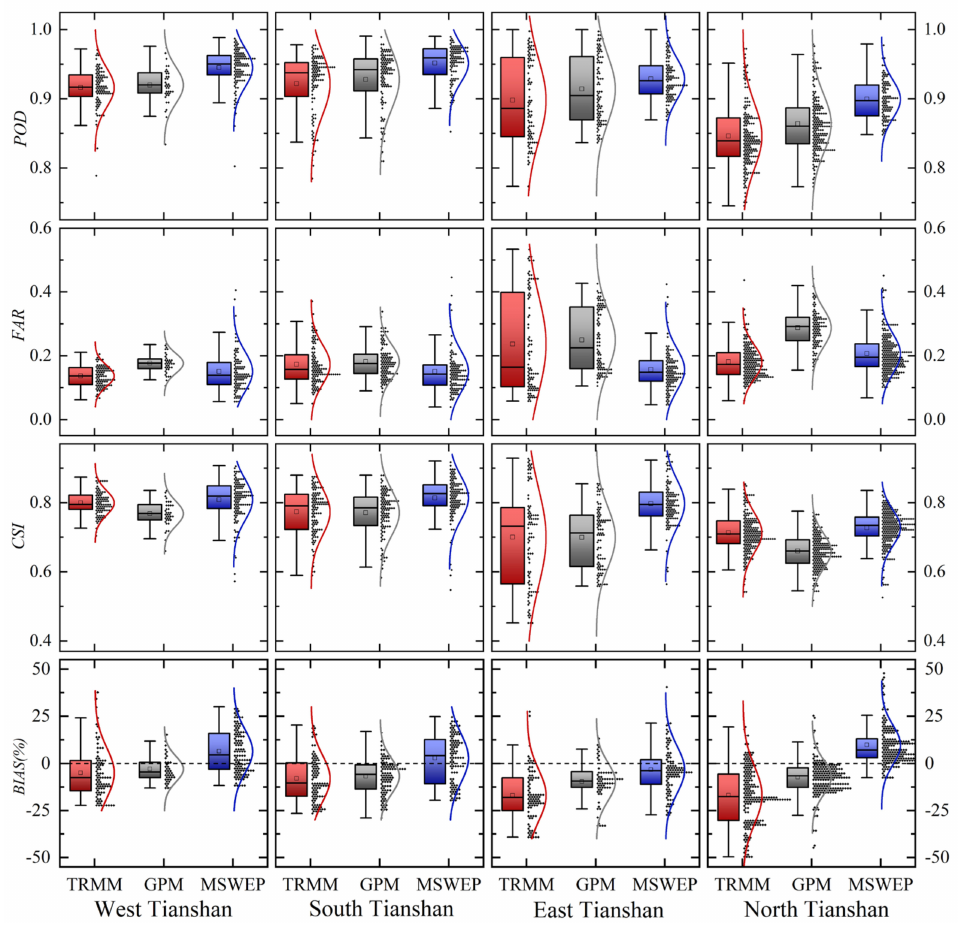
Figure 5. Statistical analysis of POD, FAR, BIAS and CSI of different precipitation products in different regions. In the box plot, the solid black line represents the median value, the square represents the average value, and the four horizontal lines from top to bottom are the upper edge line, upper quartile, lower quartile, and lower edge, respectively, and the hollow black point represents the outliers, and the scatter and curve reflect the normal distribution of